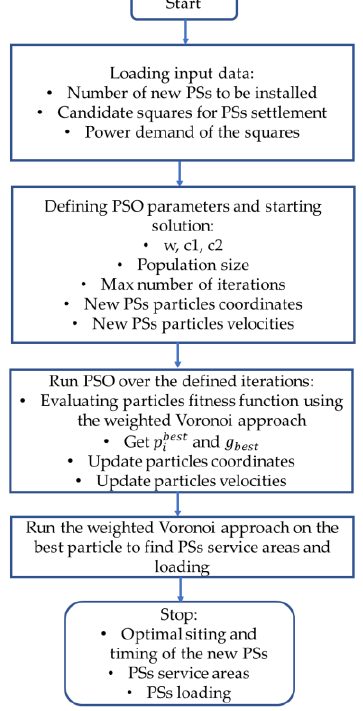
Figure 16. Flowchart of the optimization approach.